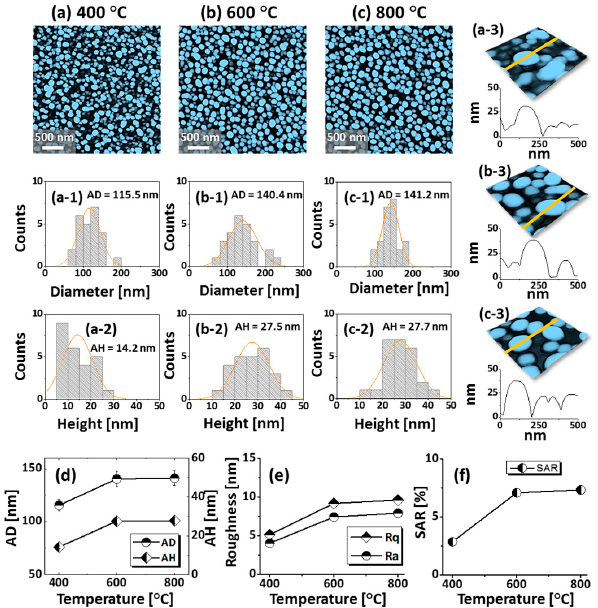
Figure 4. Spherical tiny AuAgPd alloy NPs fabricated with relatively thinner tri-layers (6 nm) by annealing between 400 and 800 °C for 450 s. The tri-layers consisted of 2 nm Au, Ag, and Pd each. ( a – c ) AFM top-views of 3 × 3 µm 2 . ( a - 1 – c - 1 ) Diameter distribution histograms. ( a - 2 – c - 2 ) Height distribution histograms. ( a - 3 – c - 3 ) Enlarged 3D side-views and cross-sectional line profiles. ( d – f ) Summary plots of average diameter (AD), average height (AH), roughness, and SAR.